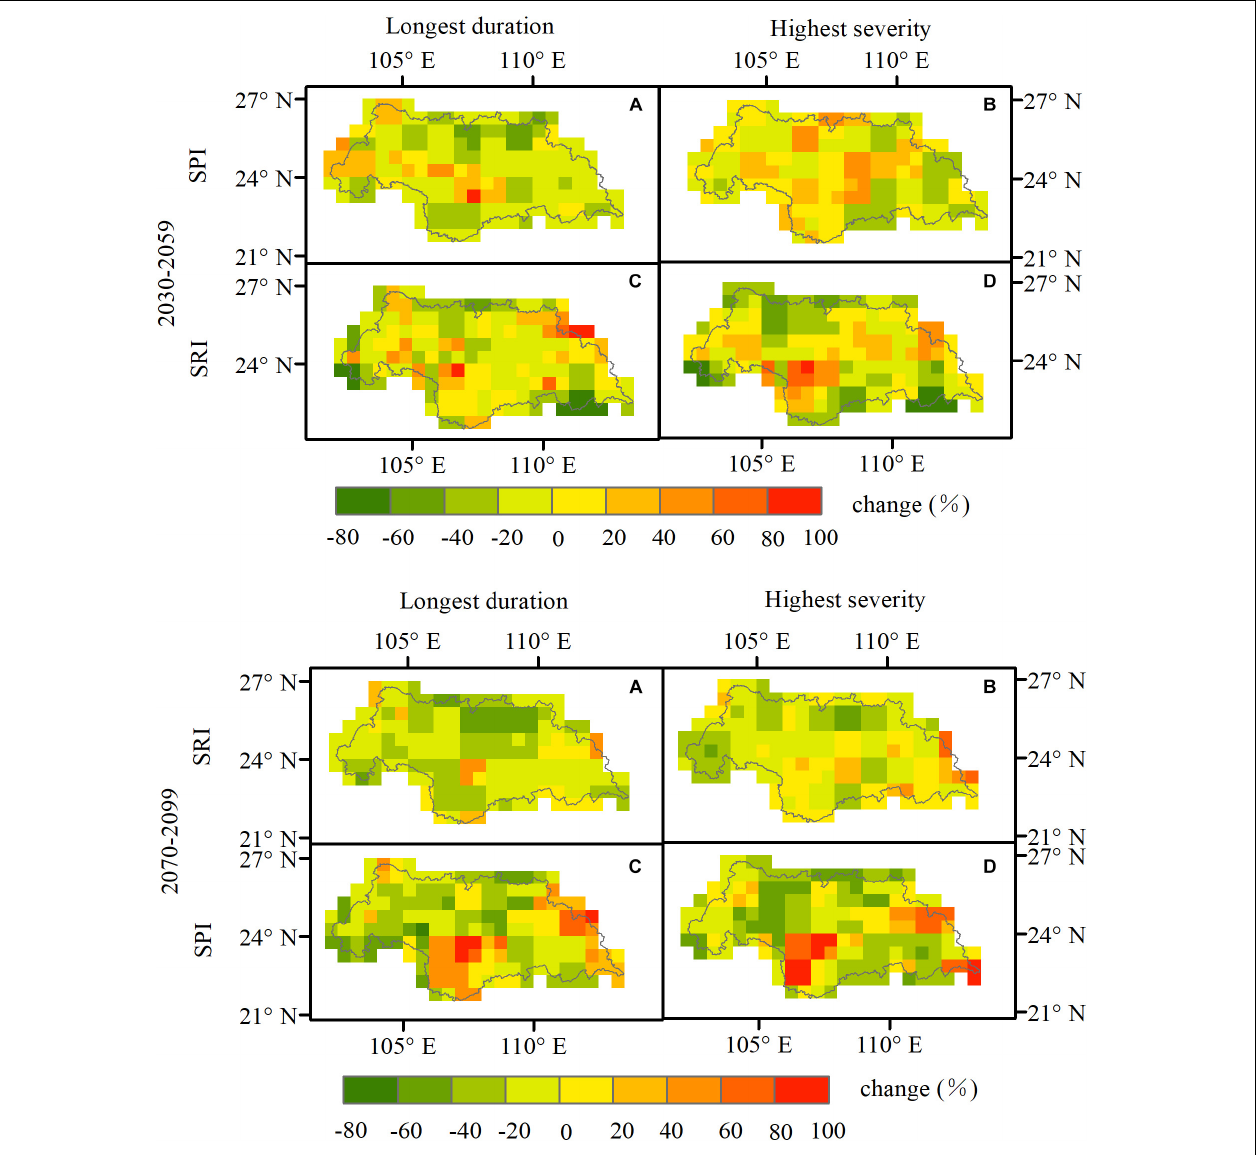
FIGURE 5 | Changes in the characteristics of extreme meteorological droughts for the SPI between the future periods (2030–2059 and 2070–2099) and the historical period (1971–2000): (A) longest duration and (B) highest severity, and changes in the characteristics of extreme hydrological droughts for the SRI between the future periods (2030–2059 and 2070–2099) and the historical period (1971–2000): (C) longest duration, and (D) highest